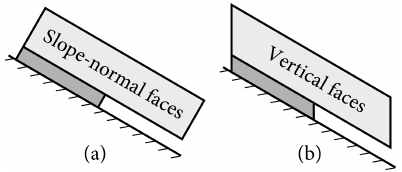
Figure 13. Boundary conditions in PST experiments: (a) slope- normal and (b) vertical upslope and downslope faces.